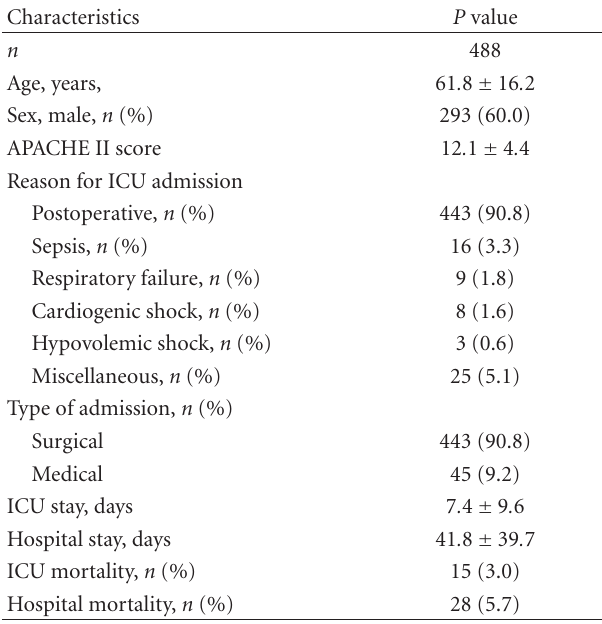
Table 1: Patient demographics and clinical